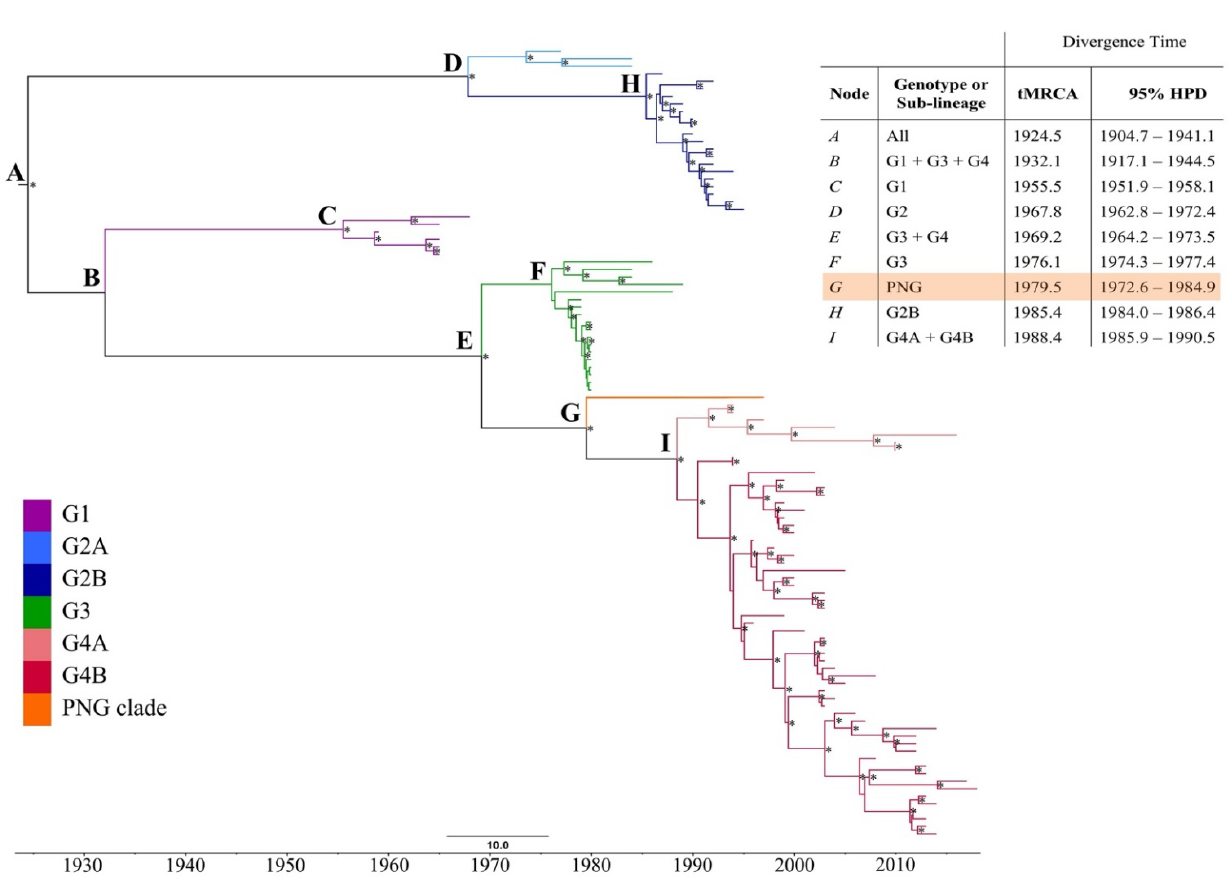
Figure 1. Maximum clade credibility (MCC) phylogeny of the 105-taxon Ross River virus (RRV) dataset. Clades are coloured for the genotype or sub-lineage as characterised by the maximum likelihood phylogeny of Figure S1 (see key in lower left). Posterior probability values of > 0.70 are presented above nodes, as indicated by asterisks (*). The table in the upper-right corner presents the mean time to most recent common ancestor (tMRCA) with error reported as the 95% highest probability density (95% HPD) for each major genetic group of RRV. The PNG clade has been highlighted within the table.